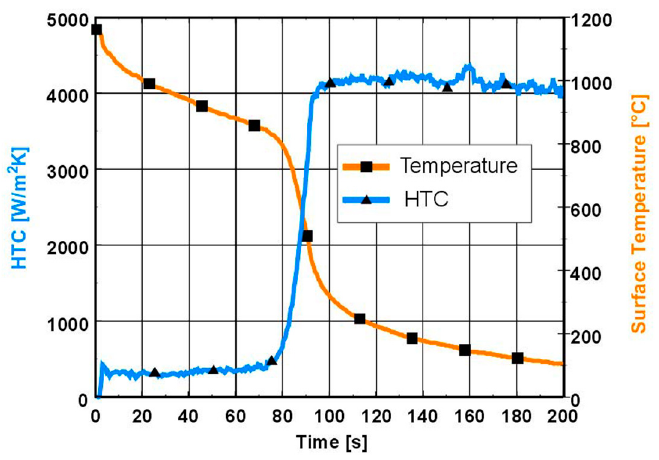
Figure 1. Example of typical record of spray cooling experiment where the Leidenfrost temperature is reached (reproduced from [4], with permission from authors, 2005).